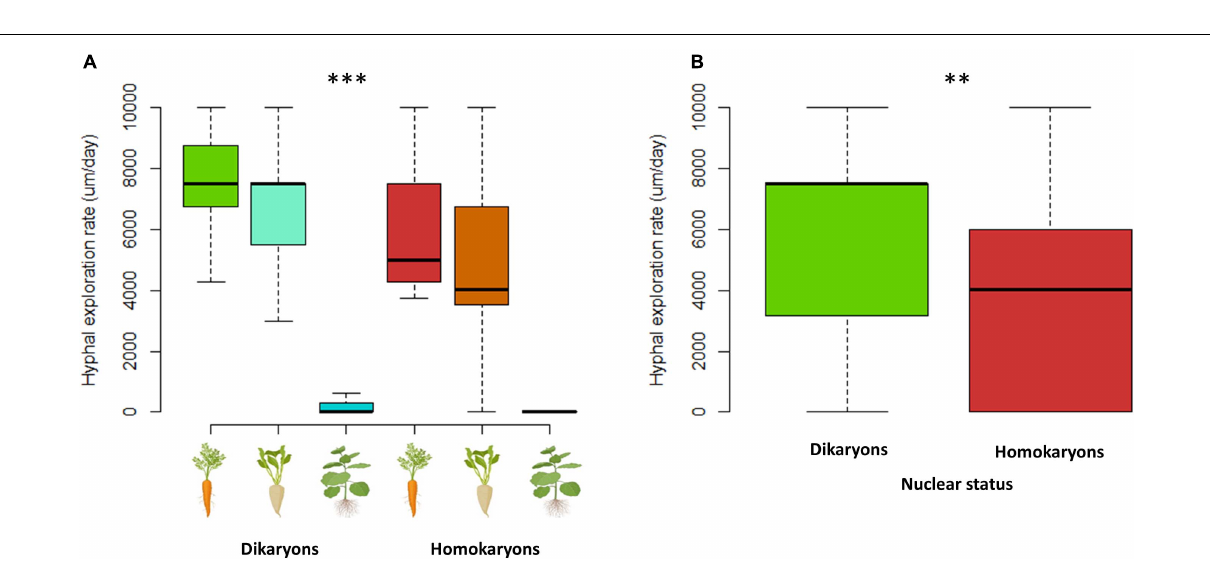
FIGURE 9 | Hyphal exploration speed (A,B) variation between dikaryotic and homokaryotic strains of Rhizophagus irregularis per root organ culture host used in the study. (A) Trait variation per nuclear status and per ROC. (B) Trait variation per genetic. ** indicates statistical significance at < 0.01 and *** indicates statistical significance at <